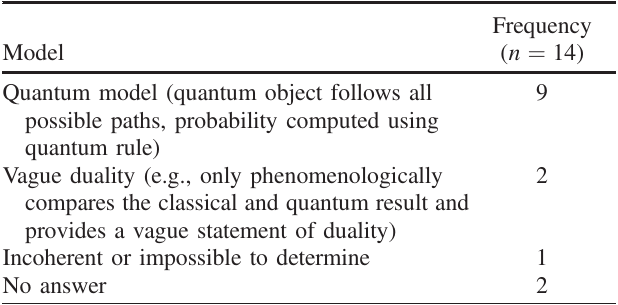
TABLE V. Principal idea used by students in the answer to T3 (the electron and two-slit experiment).